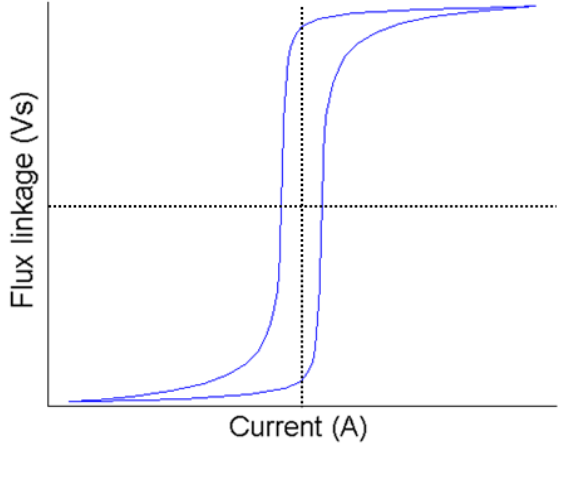
Figure 2. Hysteresis